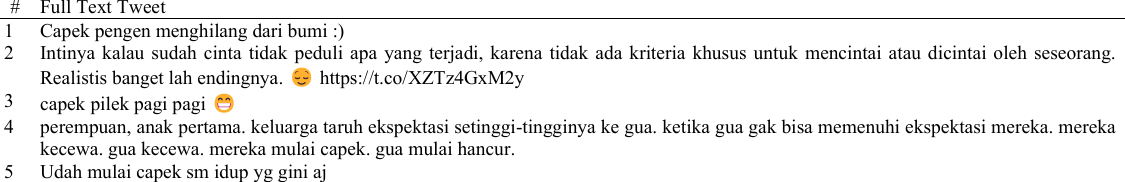
TABLE 1 T WITTER D ATA C OLLECTION R ESULTS